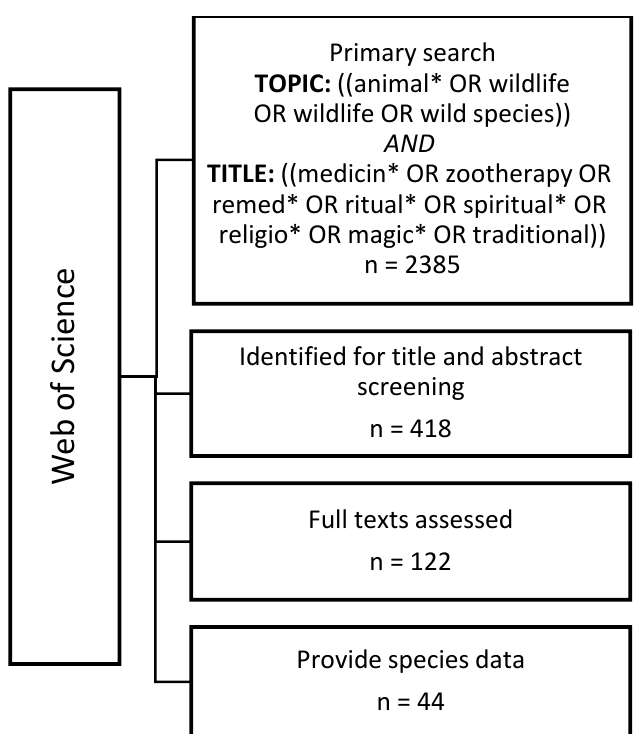
Figure A1.1: Web of Science literature search terms and process.